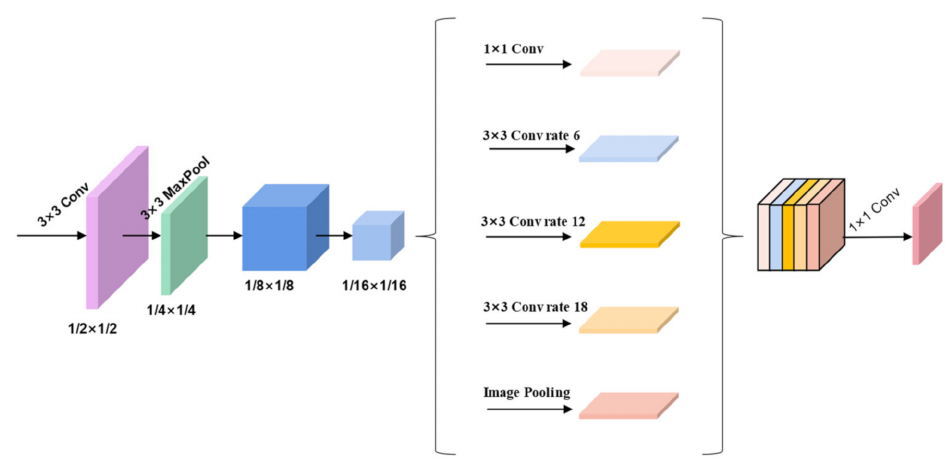
Figure 2. The structure of the Spatial Pyramid Structure